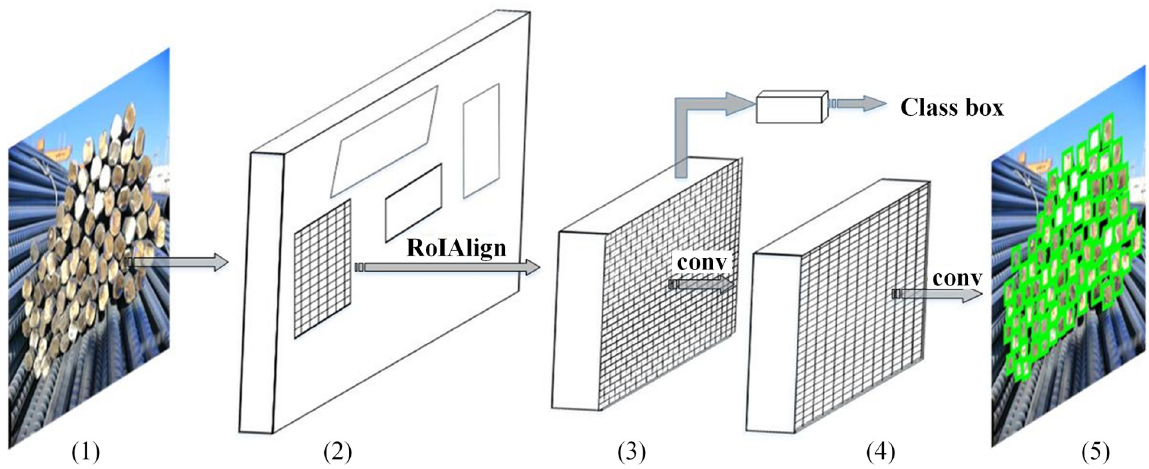
Fig 1. (Color online)Mask R-CNN framework. (1) original rebar image, (2) feature map and region proposals, (3) fixed size feature map, (4) bounding box regression, and (5) final bounding box of rebar.